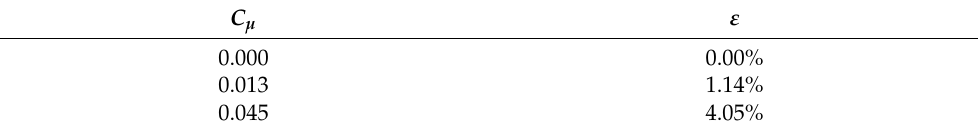
Table 3. Jet power consumption ratios corresponding to the chosen jet momentum coefficients.